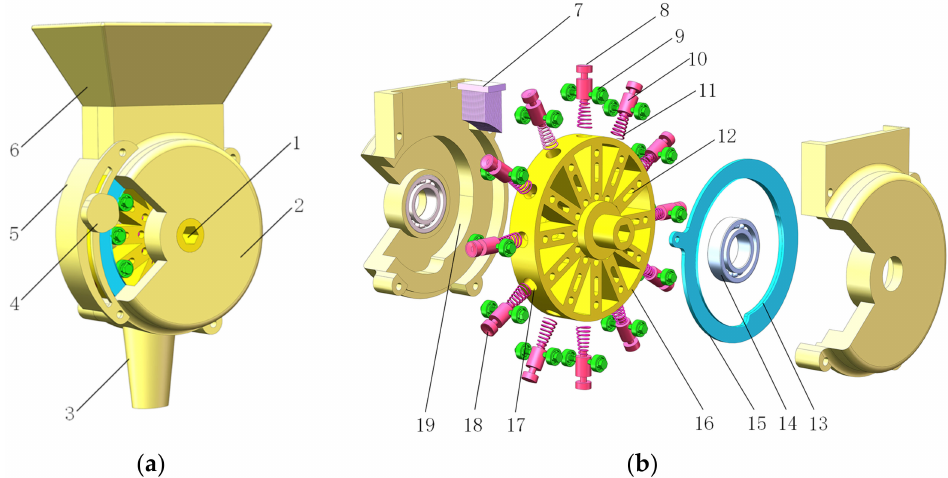
Figure 1. Configuration diagram of seed-metering device. ( a ) Front view; ( b ) axonometric drawings. 1. Seeding shaft, 2. shell, 3. seed tube, 4. adjusting handle, 5. adjusting track, 6. seedbox, 7. seed brush, 8. forced seeding mechanism, 9. rolling bearing, 10. push shaft, 11. spring, 12. sliding groove, 13. inner track, 14. supporting bearing, 15. adjusting mechanism, 16. seeding wheel, 17. hole, 18. guiding socket, and 19. fixed